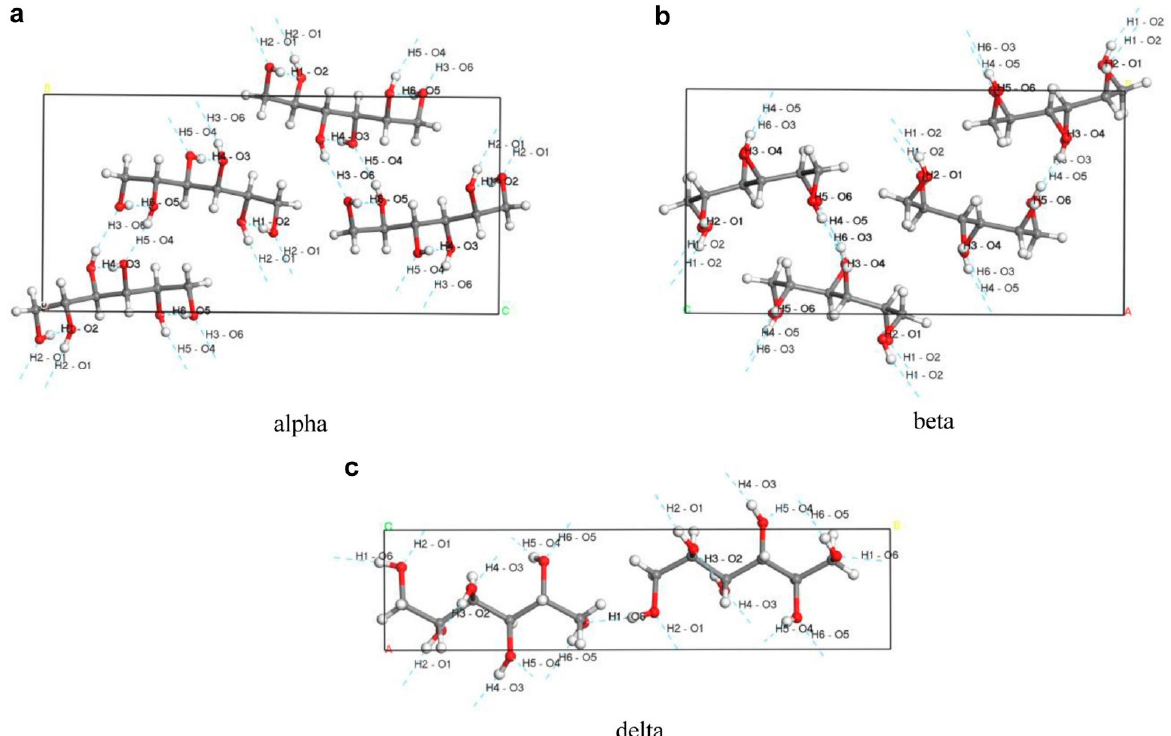
Figure 2 [19]. The crystal structure parameters of different mannitol forms are shown in Table 1. The stability of the mannitol polymorphs is β > α > δ . Therefore, the majority of mannitol sold in the market is in the β form.